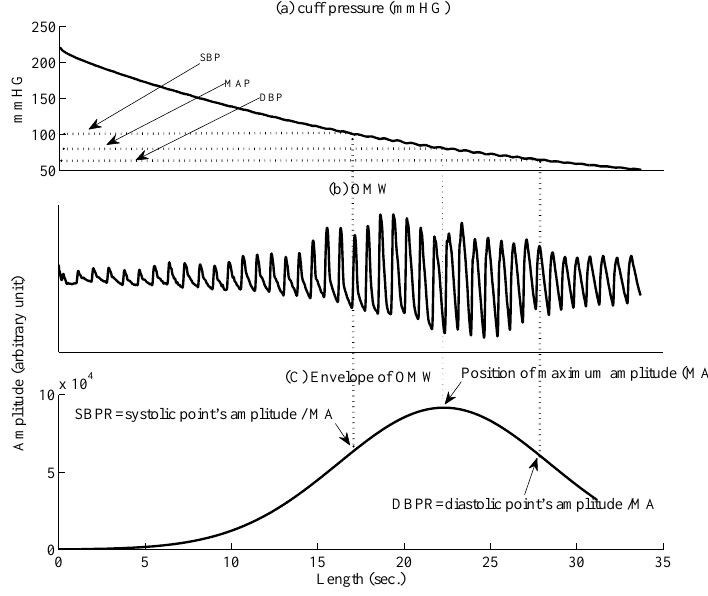
Figure 1. The concept of maximum amplitude algorithm (MAA). ( a ) cuff pressure (CP); ( b ) oscillometric wave (OMW); ( c ) Envelope of oscillometric wave